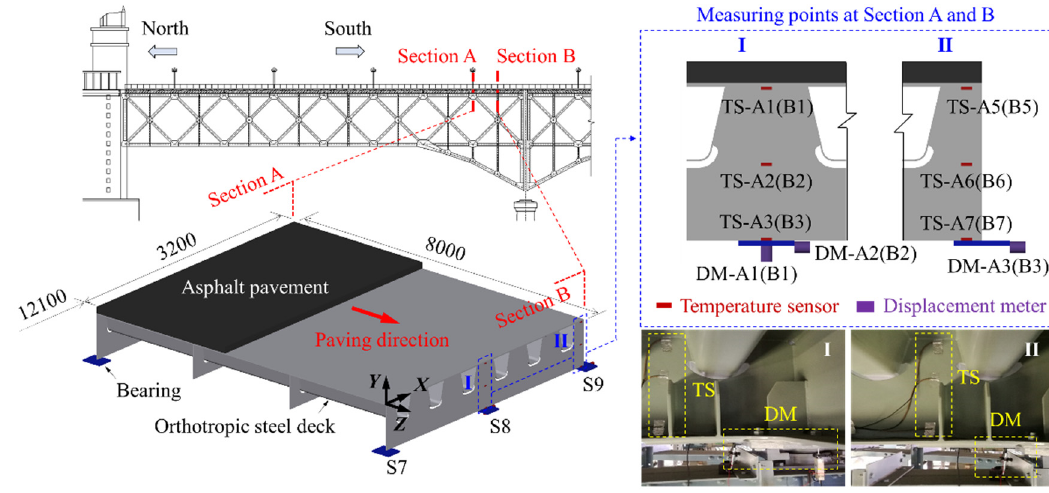
Figure 4. Arrangement of temperature sensors and displacement meters (unit: mm).